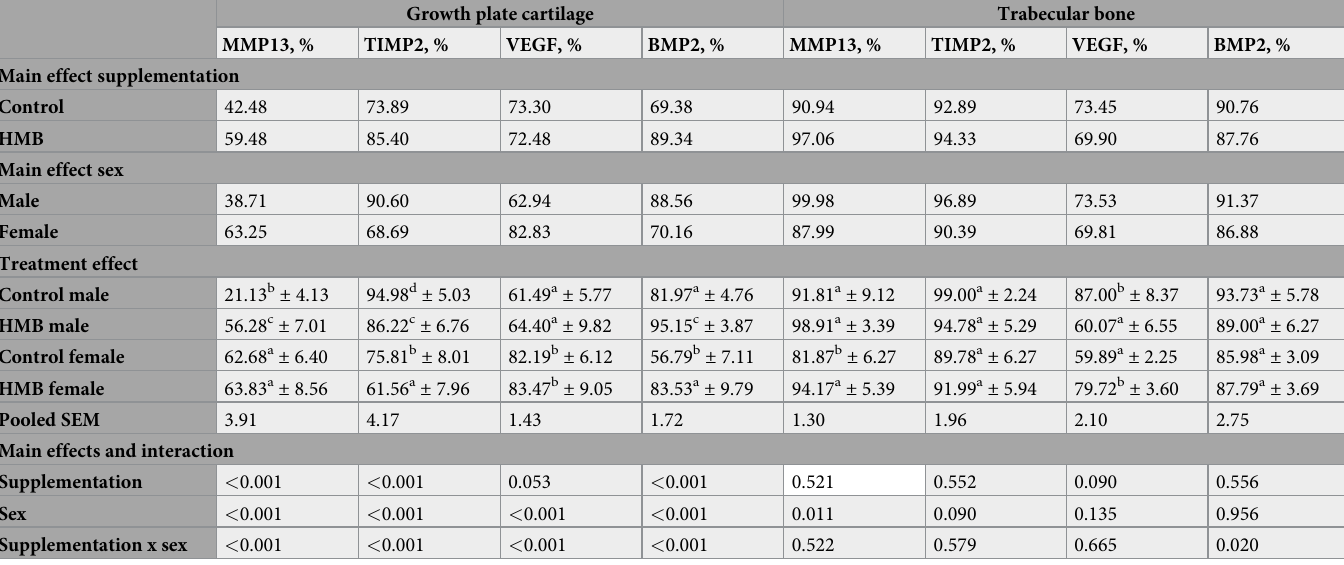
Table 7. The effect of maternal treatment with HMB on humerus growth plate cartilage and trabecular bone cells with a positive immunohistochemical reaction for MMP13, TIMP2, VEGF, BMP2 in newborn piglets. Growth plate